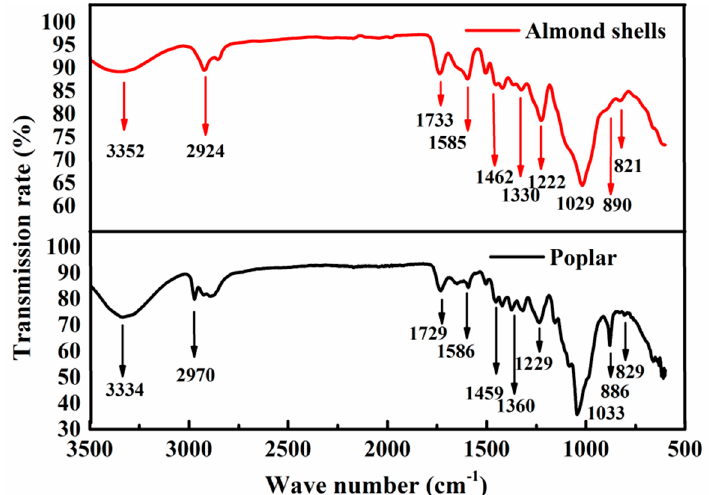
Figure 2. Infrared spectra.